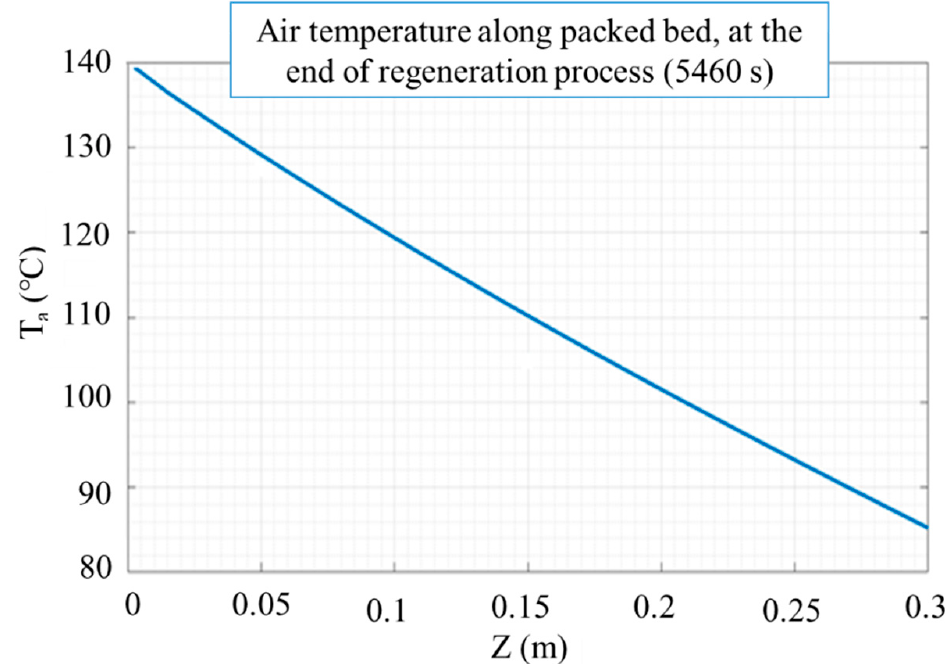
Figure 7. Air temperature distribution in the adsorbent packing bed at the end of the regeneration process.